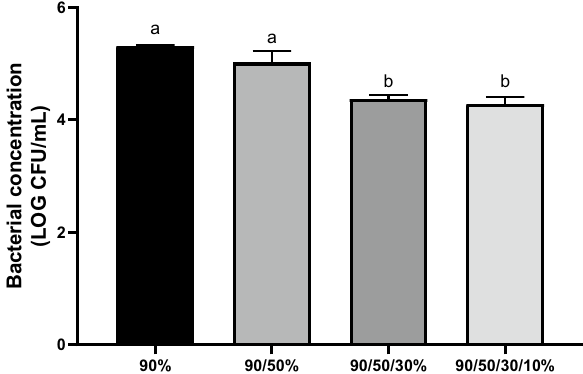
Figure 2. Total bacterial count in the algal sample after centrifugation with different Percoll density gradients. All data are presented as means ± standard deviations of three independent experiments (n = 3). Different letters on the top of the bar indicate that the means were significantly different among gradients at p ≤ 0.05 according to one-way analysis of variance followed by Tukey multiple comparison